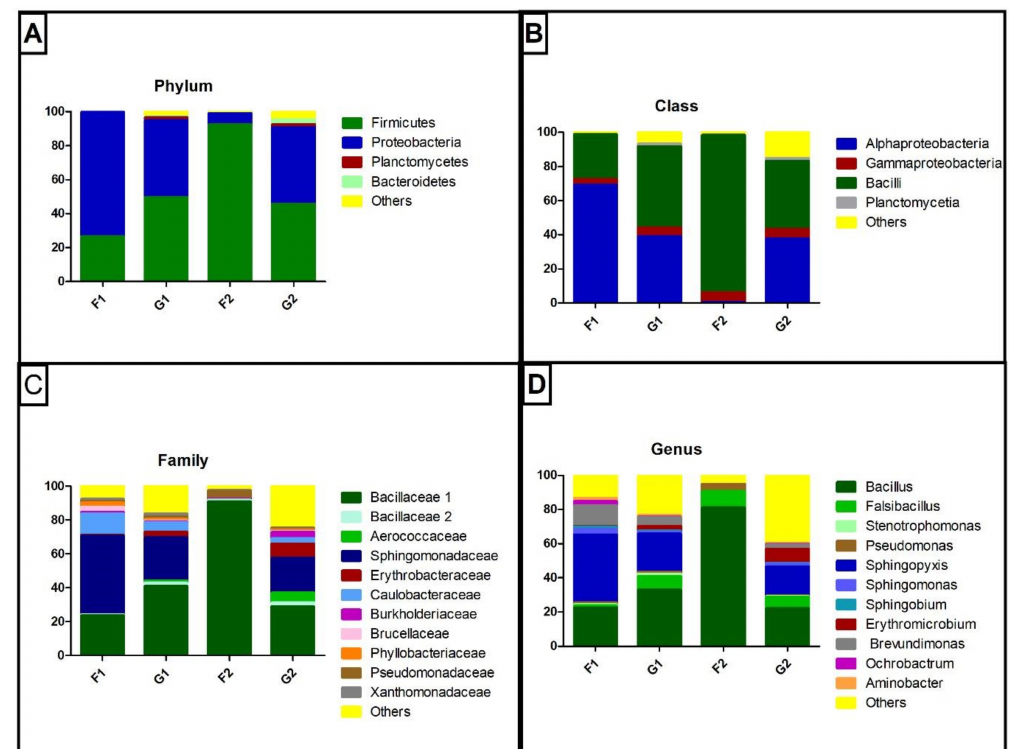
Figure 1. Taxonomic classification of reads for the cave samples: ( A ) phylum level, ( B ) class level, ( C ) family level and ( D ) genus level. Values in %.